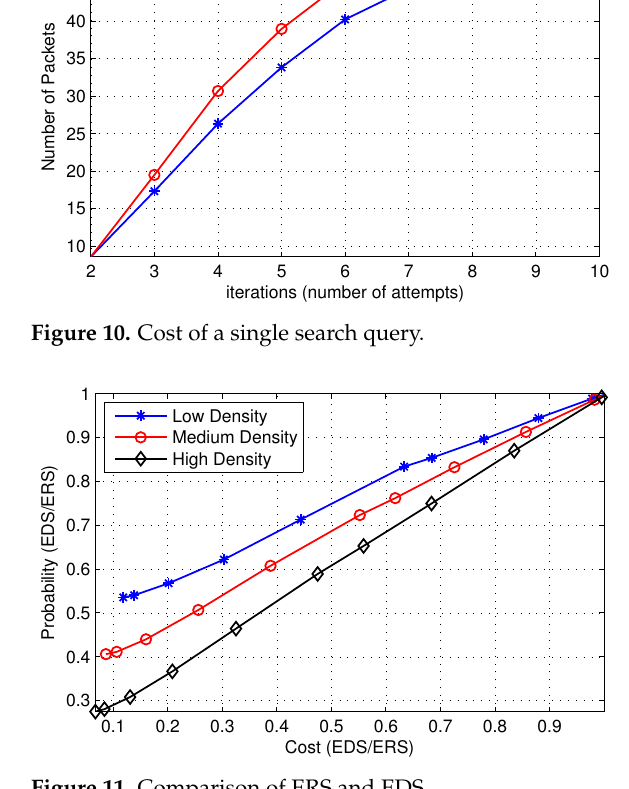
Figure 11. Comparison of ERS and